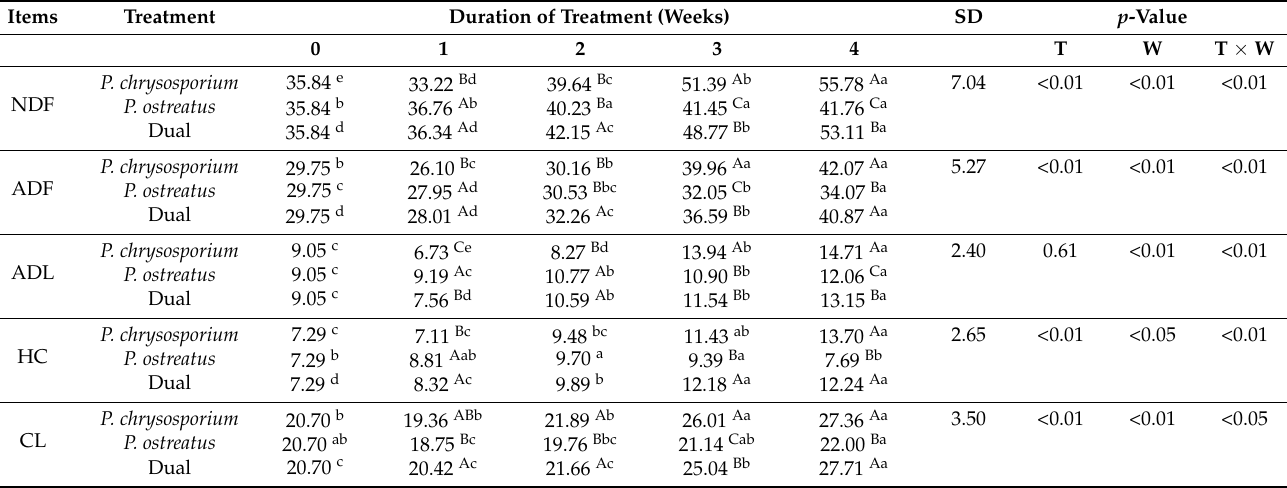
Table 2. Cell wall composition (%/DM) of white tea residue after 0, 1, 2, 3, and 4 weeks of fermentation with different fungi cultures.